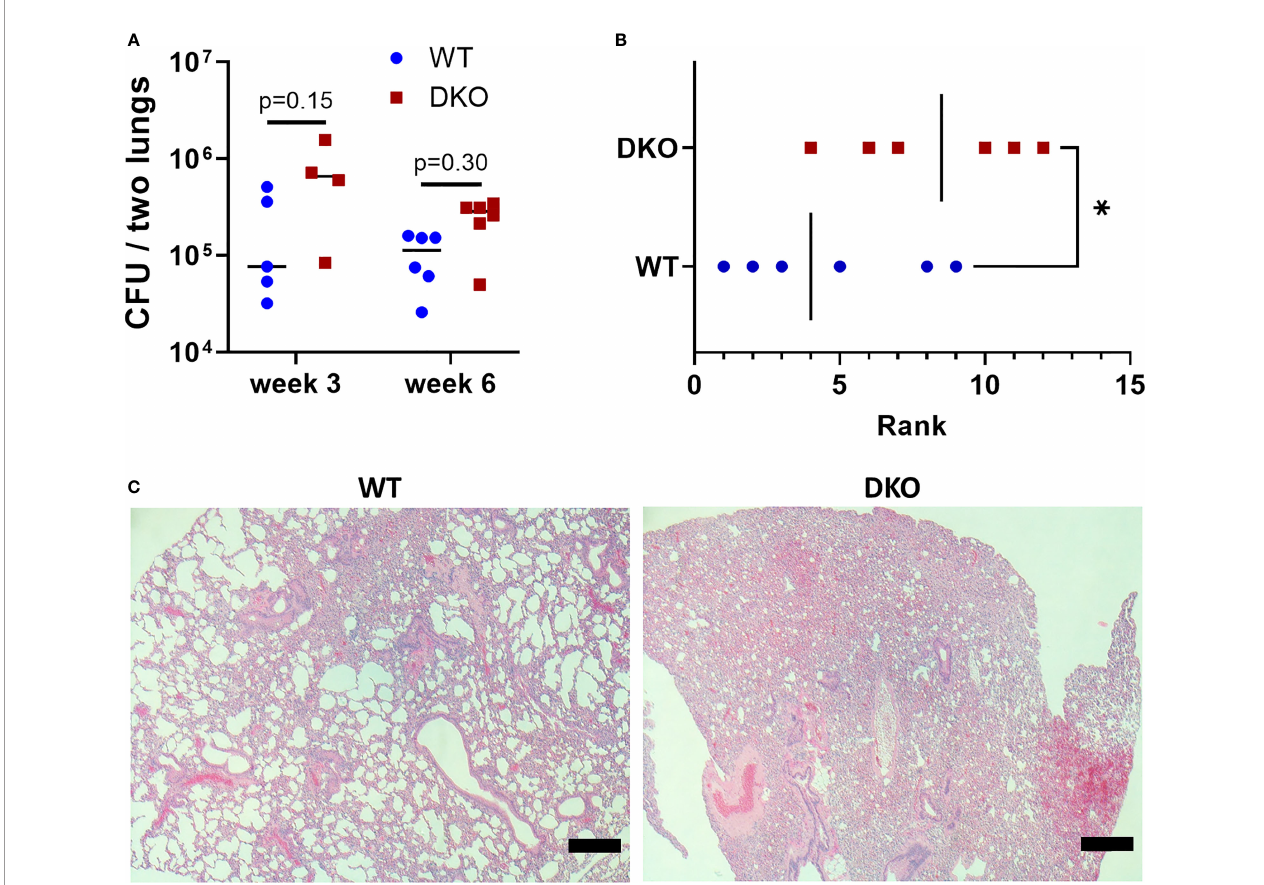
FIGURE 1 | Effect of simultaneous Mincle and Nod2 disruption on the pulmonary immune response to Mtb . (A) , total Mtb burden in both lungs of WT and DKO mice at week 3 (day 26) and week 6 (day 42) post-infection. No signi fi cant differences ( a = 0.05) in Mtb burden were found using Dunn ’ s multiple comparisons test (p values shown on graph). (B) , rank of pathology on H&E lung sections at 42 days post-infection. Ranking was obtained from the median rank of seven blinded individuals. *p = 0.0465 with one-tailed Mann-Whitney test. (C) , representative H&E sections from WT (rank 5) and DKO (rank 10) mice. Scale bar, 200 m m. Median day 1 pulmonary Mtb load was 9 CFU. N = 4 to 6 mice per